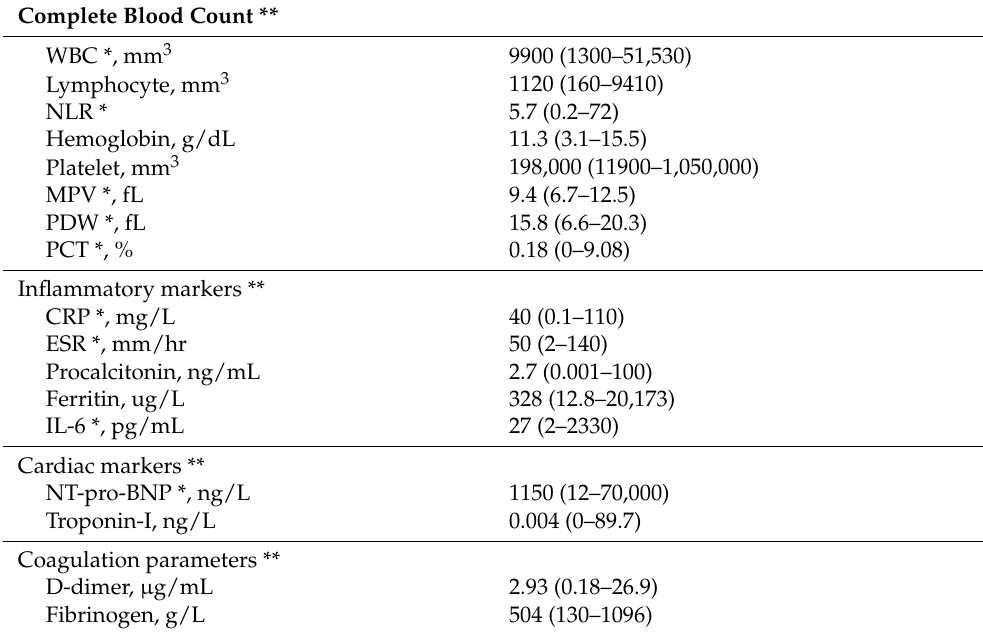
Table 2. Laboratory findings of patients at admission.